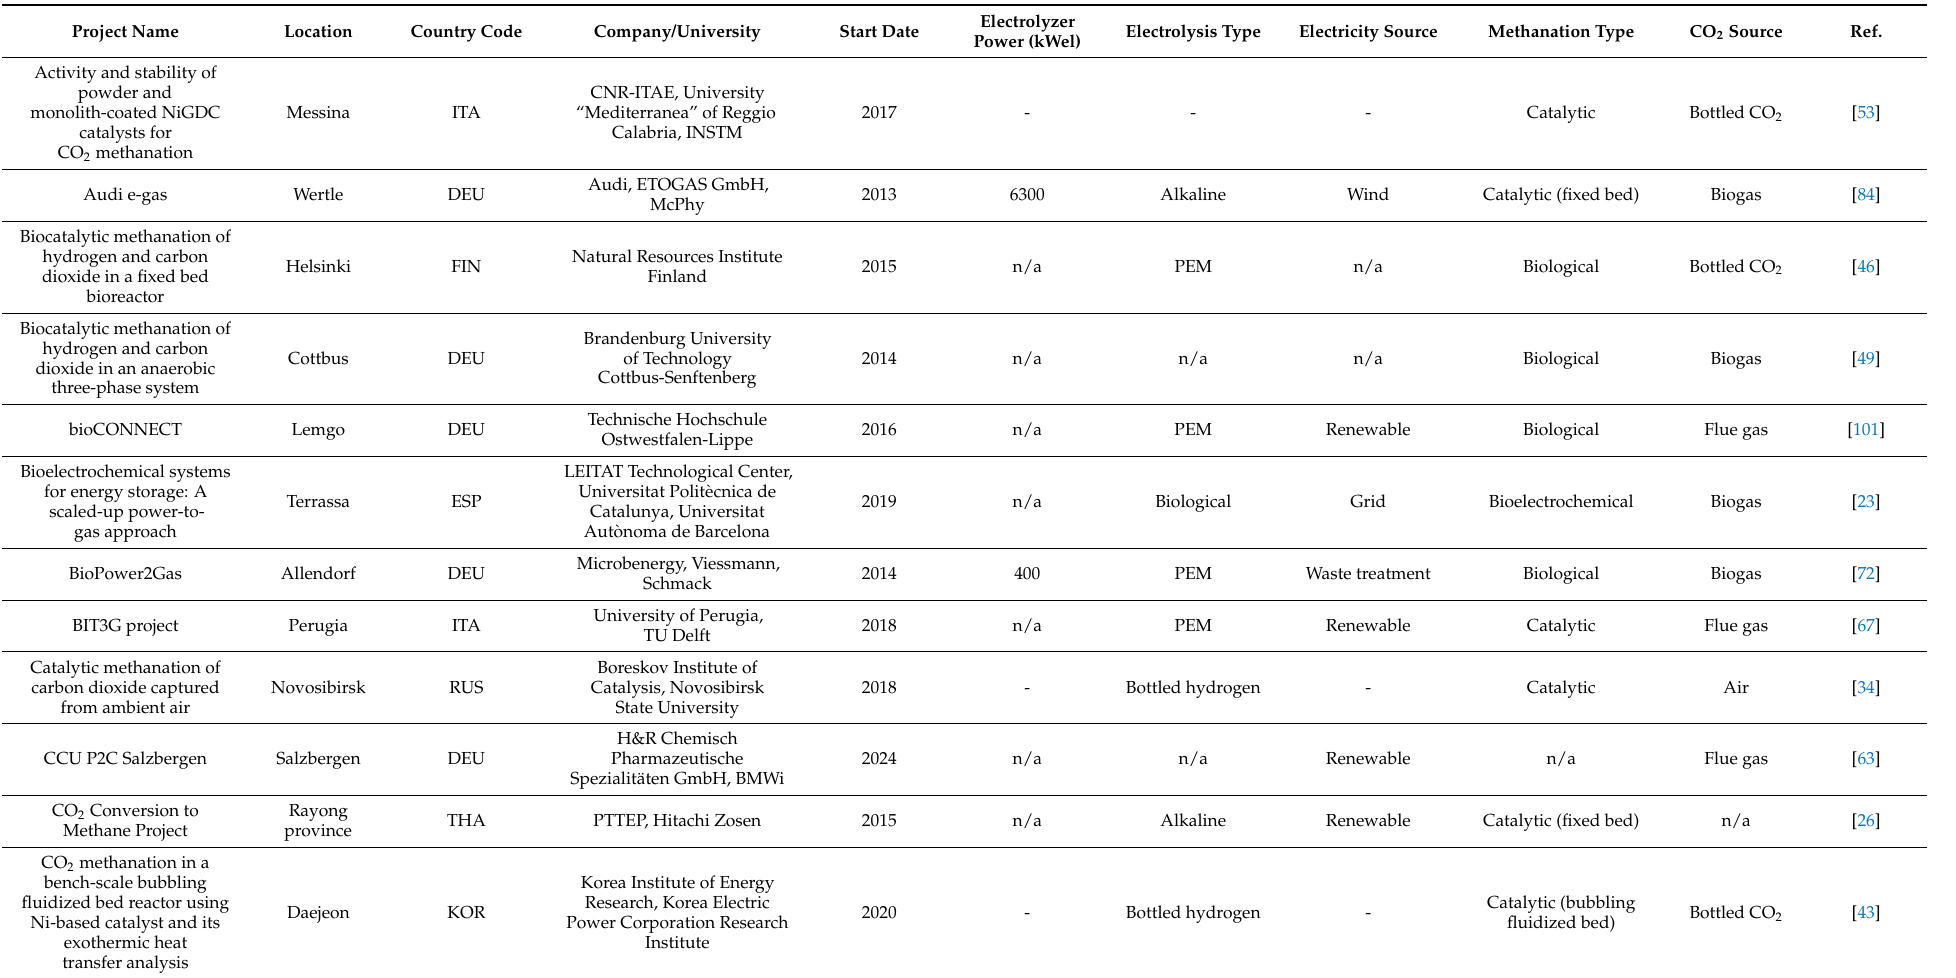
Table A1. General information on the selected projects (n/a stands for information not